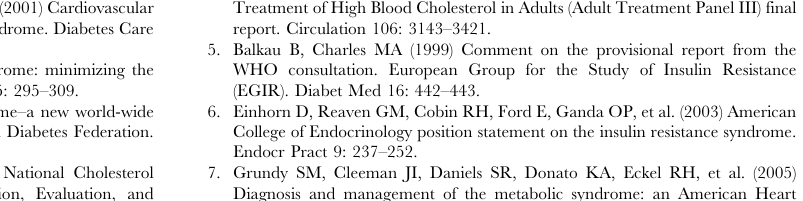
Table S1 Baseline characteristics of ARIC Study participants (N = 11,757) by race. Table S2 Baseline characteristics of CARDIA Study participants (N = 2,712) by race. Table S3 Baseline characteristics of CHS Study participants (N = 4,627) by race. Table S4 Baseline characteristics of Framingham Heart Study participants (N = 2,789). Table S5 Baseline characteristics of MESA Study participants (N = 3,870) by race. (DOC) Table S6 Pearson correlation coefficient estimates for 8 principal components used to characterize the six metabolic domains in n= 9,068 European American ARIC participants. Table S7 Pearson correlation coefficient estimates for 8 principal components used to characterize the six metabolic domains in n= 2,689 African American ARIC participants. Table S8 Pearson correlation coefficient estimates for 19 phenotypes used to characterize the six metabolic domains in n =9,068 European American ARIC participants. Table S9 Pearson correlation coefficient estimates for 19 phenotypes used to characterize the six metabolic domains in n =2,689 African American ARIC participants. Table S10 Overall and study-specific multivariate P- values for 19 known, confirmed, or possible new loci for metabolic trait dimensions in n =19,468 European American from five studies. Table S11 Fifteen potential secondary signals for metabolic trait dimensions in n =19,468 European Americans from five studies.